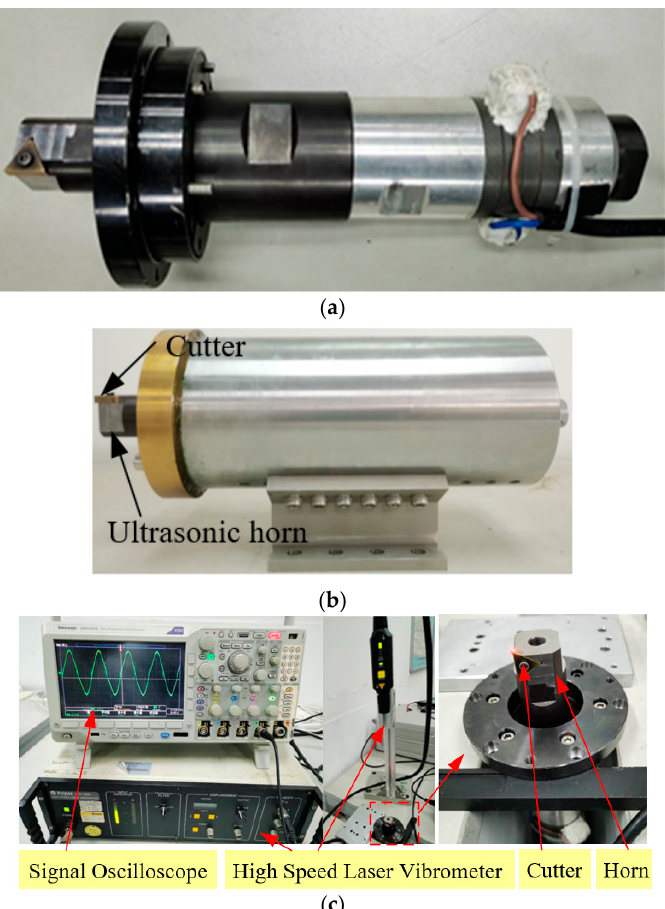
Figure 7. The assembled apparatus ( a ) without protective shell, ( b ) with protective shell, and ( c ) its testing experiments. Table 2. Testing results for ultrasonic vibration apparatus.